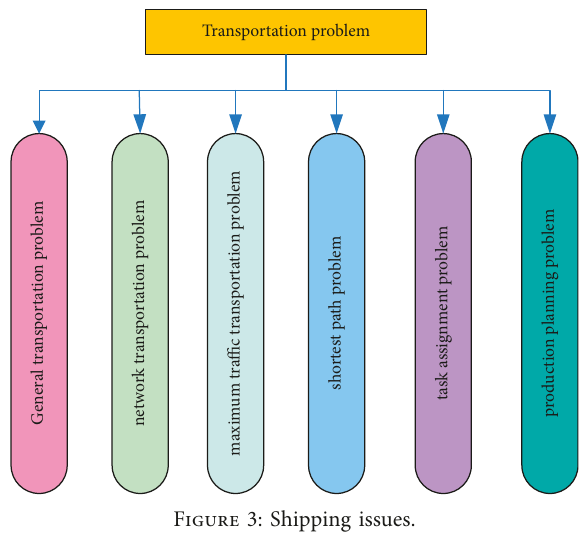
Figure 3: Shipping